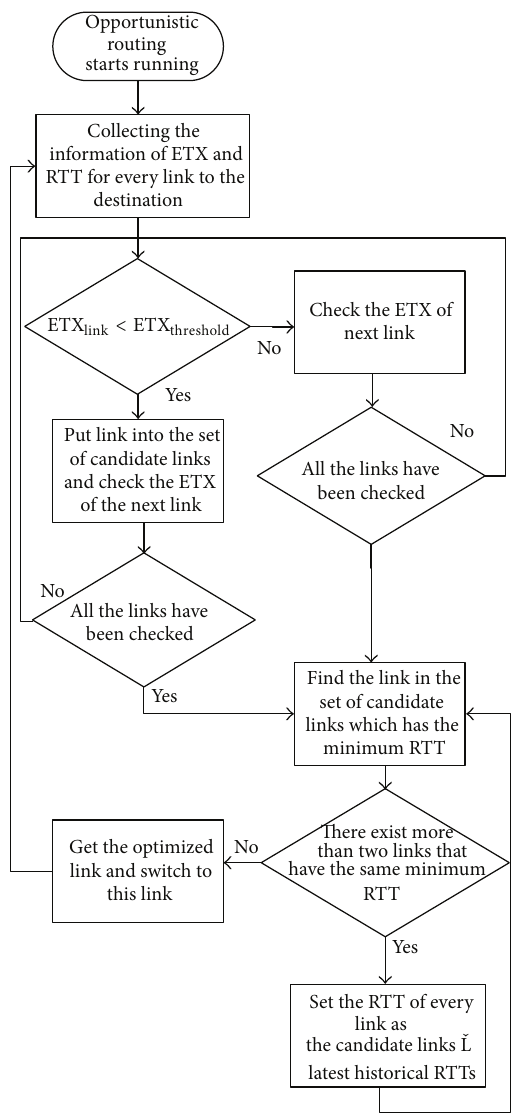
Figure 4: The process of opportunistic routing mechanism.